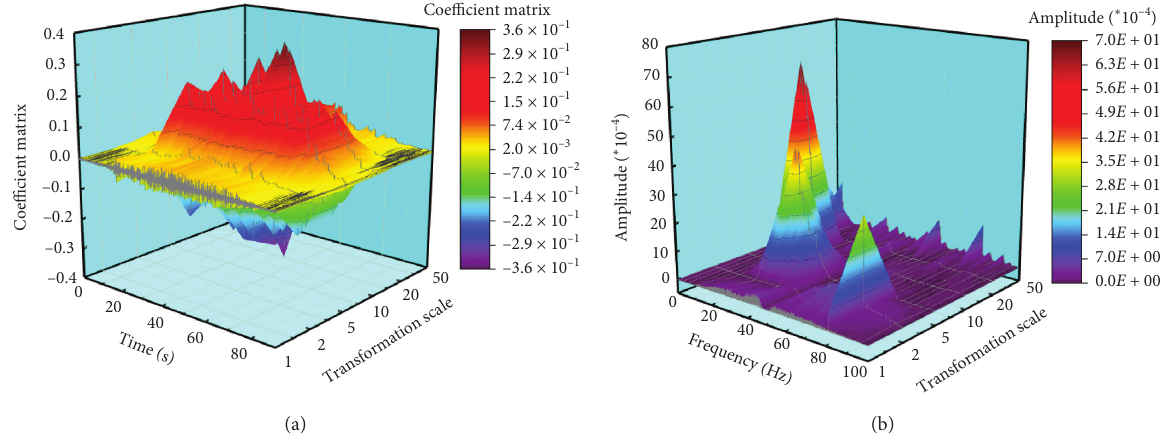
Figure 15: Three-dimensional (3D) color mapping curve for the invert of the upper-span tunnel: (a) time-transformation scale-coefficient matrix; (b) frequency-transformation scale-amplitude.